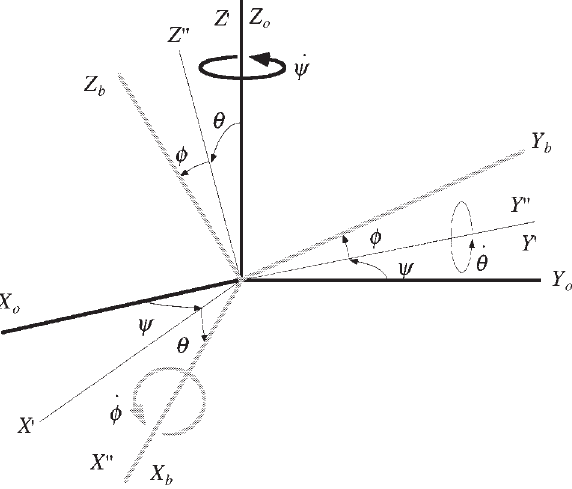
Fig. 2. The transformation from the orbital reference frame F o to the main body fixed reference frame F b